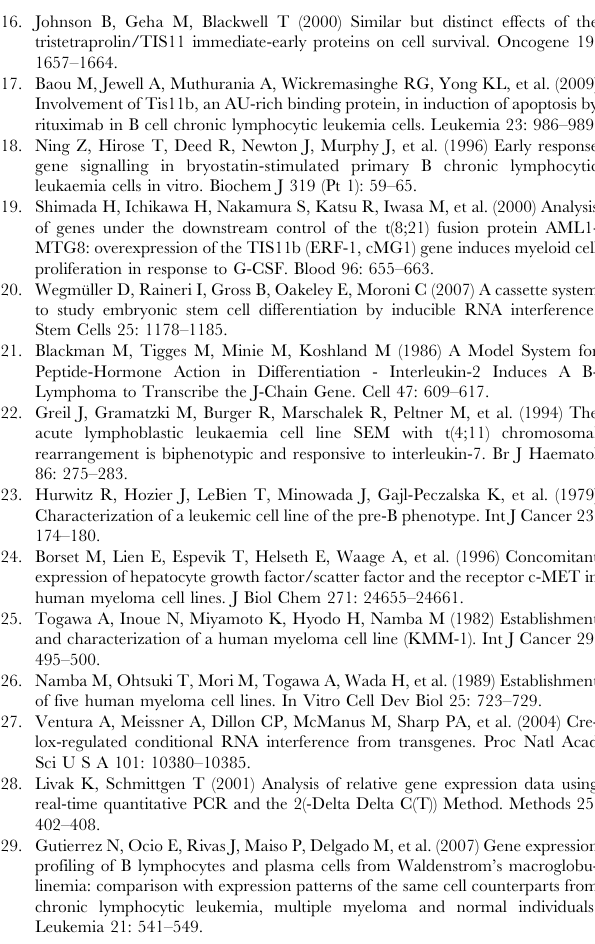
Figure S3 Genes that are down-regulated in normal plasma cells vs B cells are enriched in a set of validated ZFP36 target genes. Gene set enrichment analysis (GSEA) [48] according to up- regulation (signal-to-noise test statistic) in normal B cells relative to plasma cells is shown as a profile of running Kolmogorov-Smirnov ES score and positions of ZFP36 marker genes (black bars) in the rank ordered list of differentially expressed genes. The normalised enrichment score was 1.72 (P= , 0.00001) corrected for 1000 gene permutation tests. Of the 371 unique ZFP36 target genes [40], annotated in GSEA, 200 are represented in the leading edge. Figure S4 Graphical representation of the ARACNe network for BLIMP1 and ZFP36L1. Nodes representing the BLIMP1 and ZFP36L1 hubs are shown enlarged. Only first neighbours of these hubs are shown in the module. Nodes representing inferred BLIMP1 targets (significantly up-regulated in normal B cells) are blue; nodes representing inferred ZFP36L1 targets (significantly up-regulated in normal plasma cells) are red. Network graphics (spring-embedded layout) were generated using Cytoscape version 2.6.0. Table S1 Oligonucleotide primers designed for construction of zfp36l1 shRNA and scramble sequences.